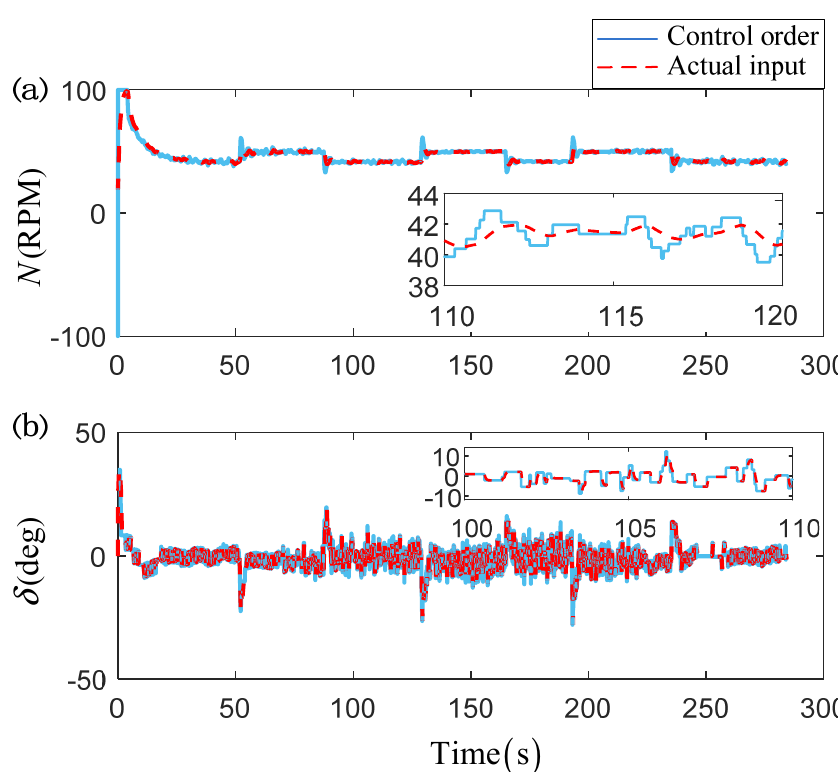
Figure 5. The position and heading angle errors for USVs: ( a ) error curves of position; ( b ) error curves of heading angle.